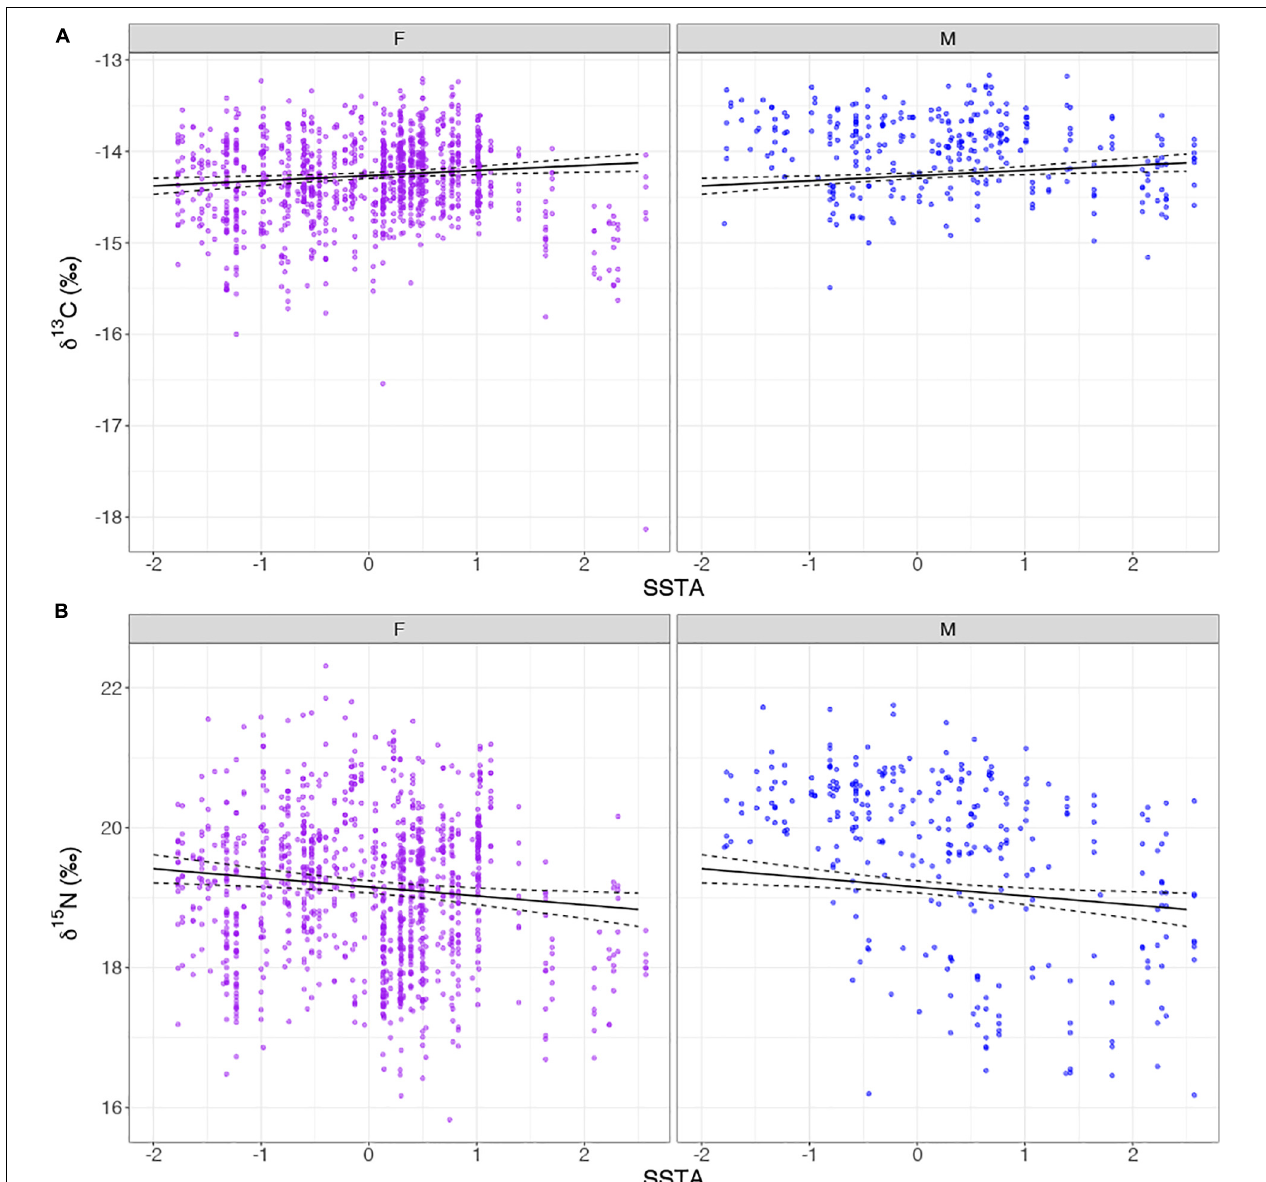
FIGURE 5 | Prediction plot for best fitted values for (A) δ 13 C and SSTA by Sex and (B) δ 15 N and SSTA by Sex. The black line represents the model’s estimated average stable isotope value measured in parts per thousand ( ) across various sea surface temperature anomaly (SSTA) recordings ( ◦ C). The area within the dashed black lines represents the uncertainty in the average stable isotope value (95% confidence interval). F = Females (purple) and M = Males (cid:104)